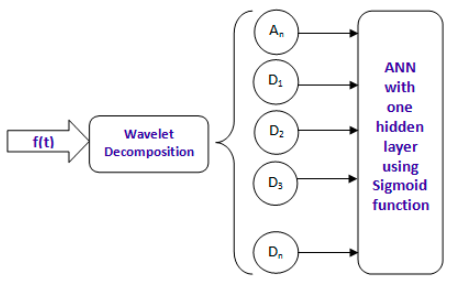
Figure 2. Schematic diagram of the hybrid wavelet neural network (WNN) approach model.